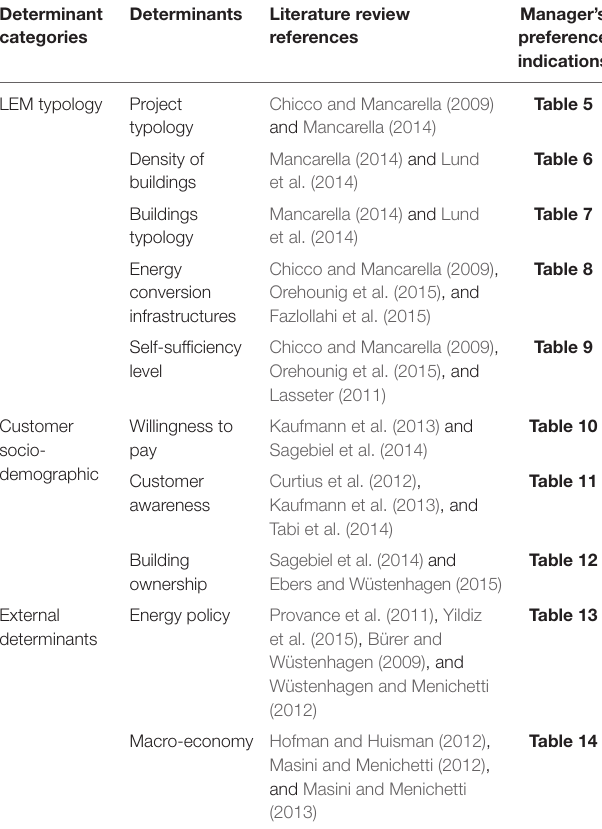
TaBle 4 | Overview on selected main determinants and manager’s preference indications.